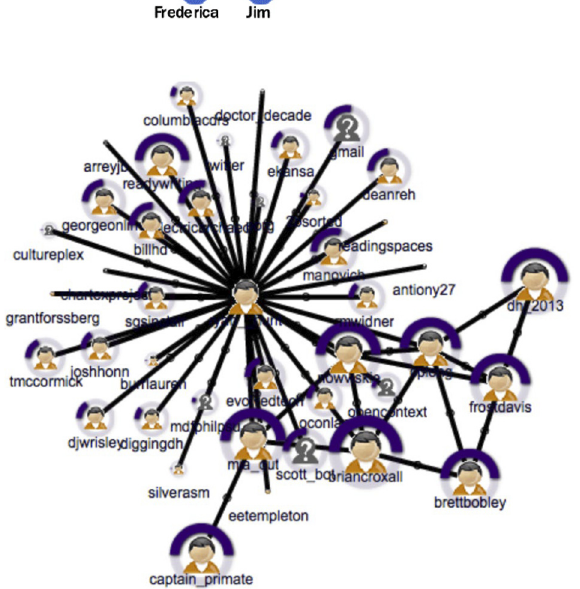
Figure 1. Network